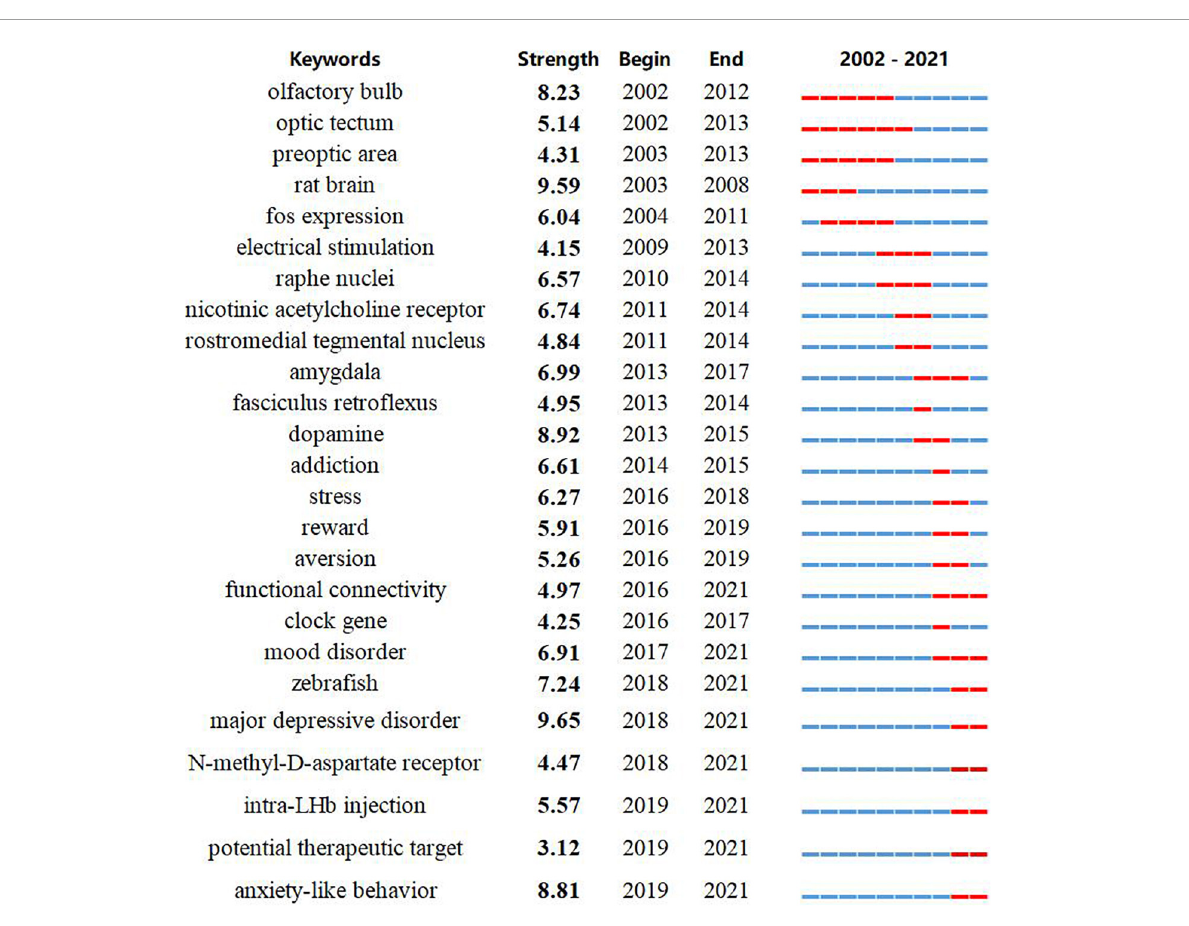
FIGURE4 Keywords with the strongest citation bursts in original articles between 2001 and 2021. The timeline is depicted as a year-sliced blue line, and the time interval of a burst is marked as a red section on the blue timeline to indicate the beginning/ending year and the duration of a citation